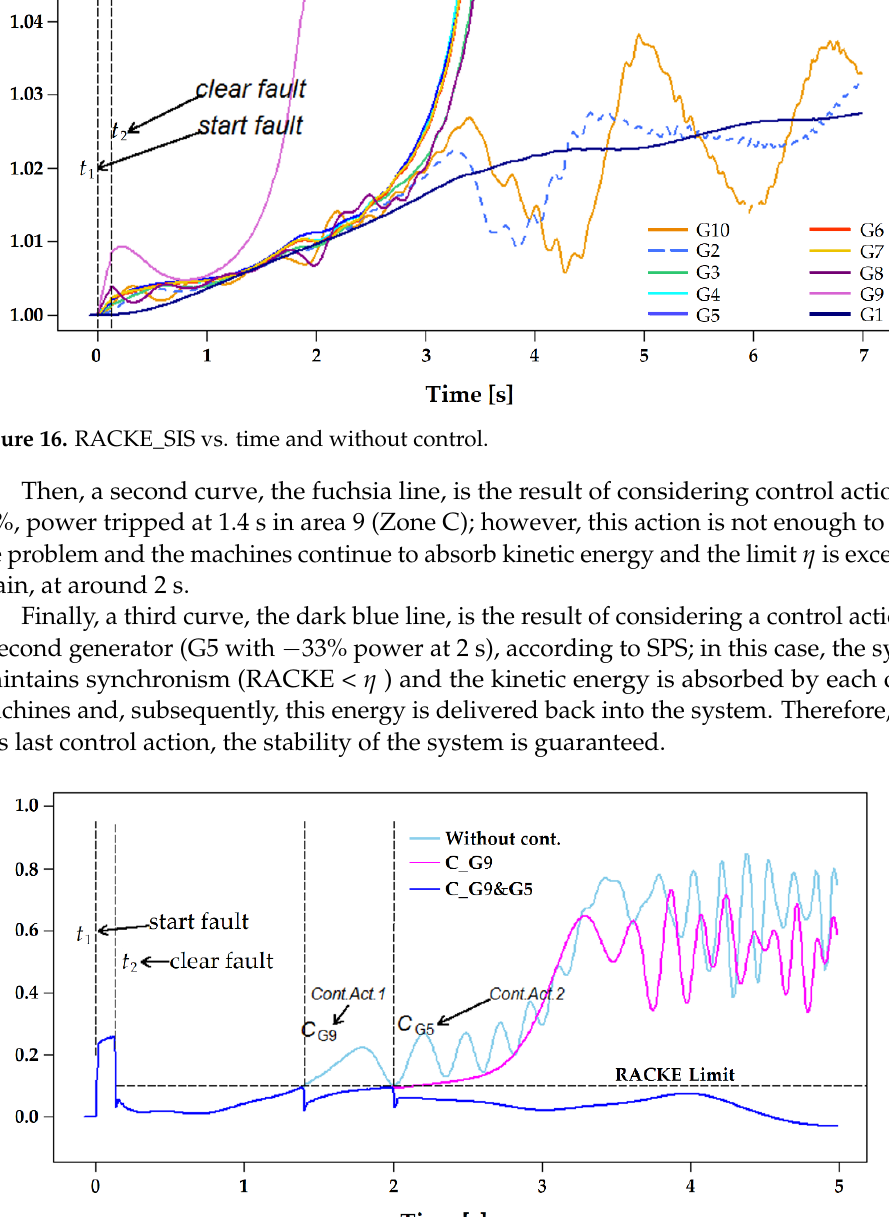
stability. Generator G9 is the first to present a higher oscillation in time and it accelerates